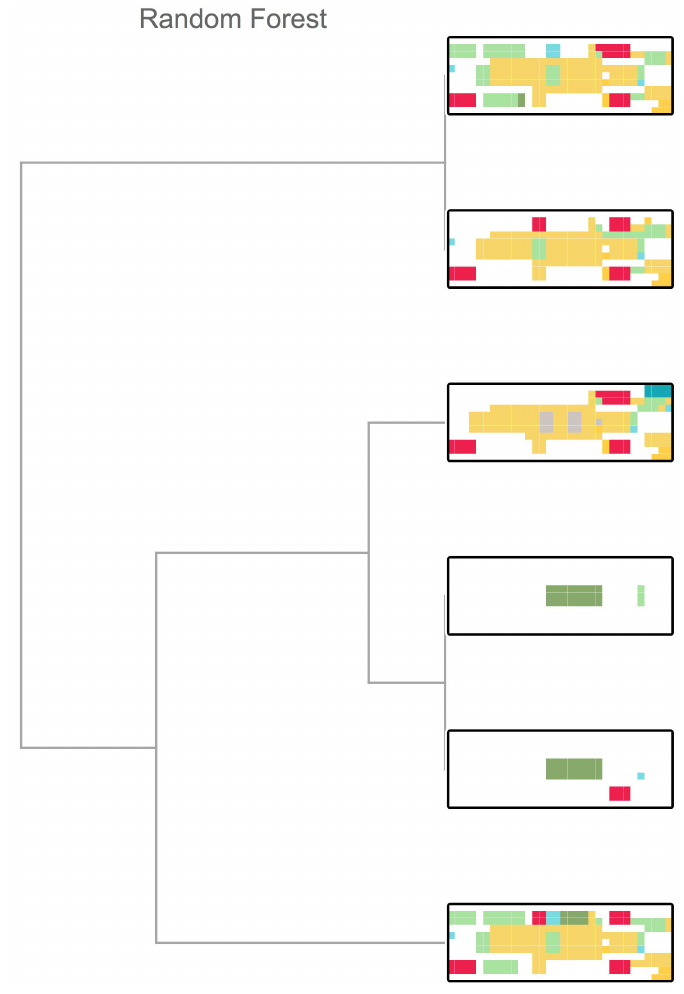
Figure 12. Random forest